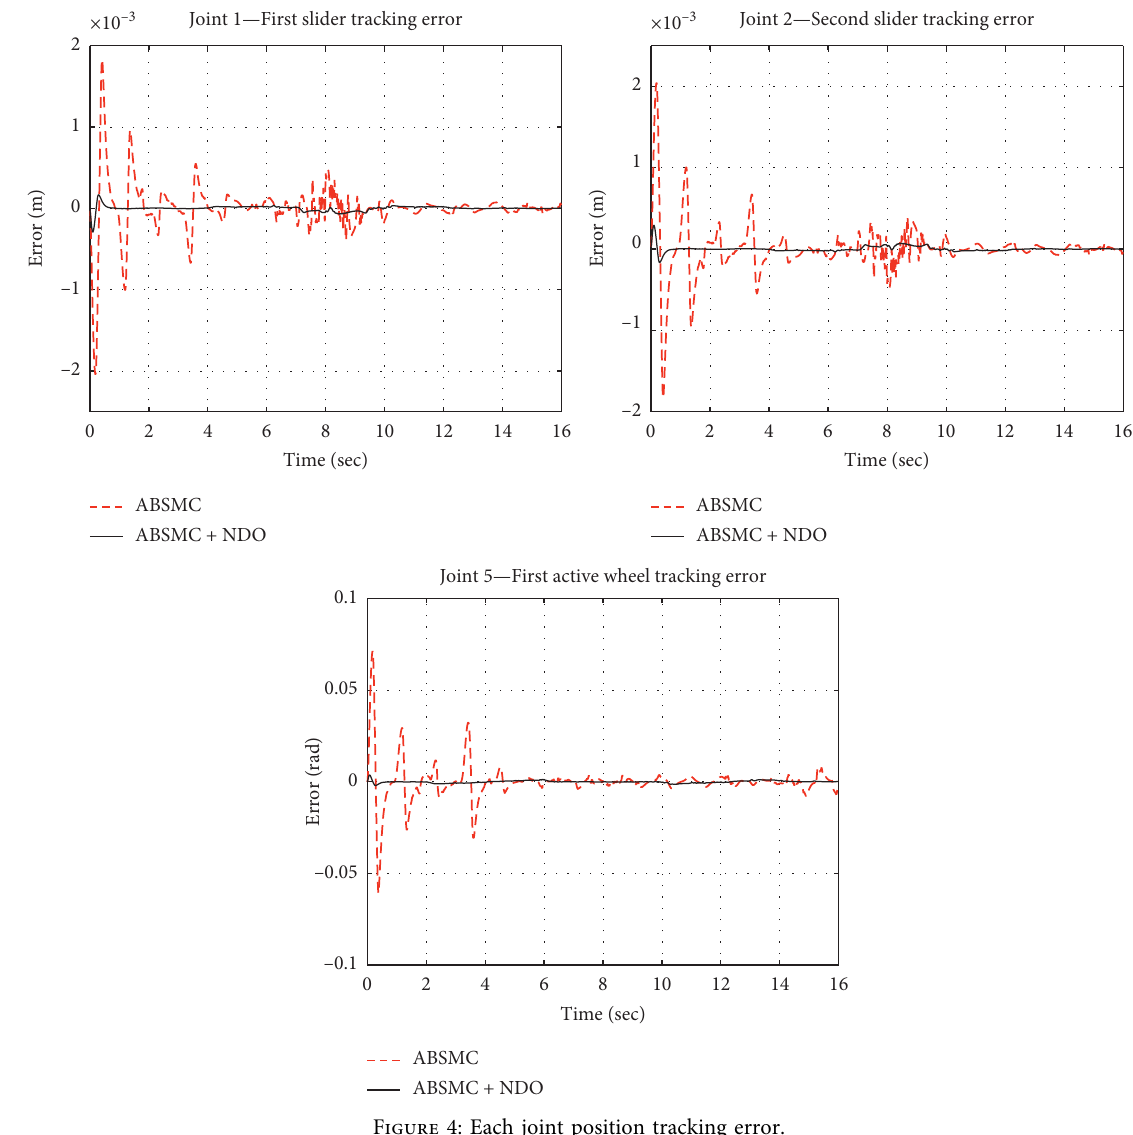
Figure 4: Each joint position tracking